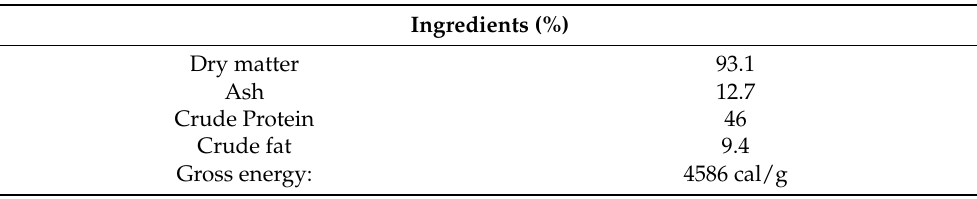
Table 1. Chemical composition of C. vulgaris (DM basis).